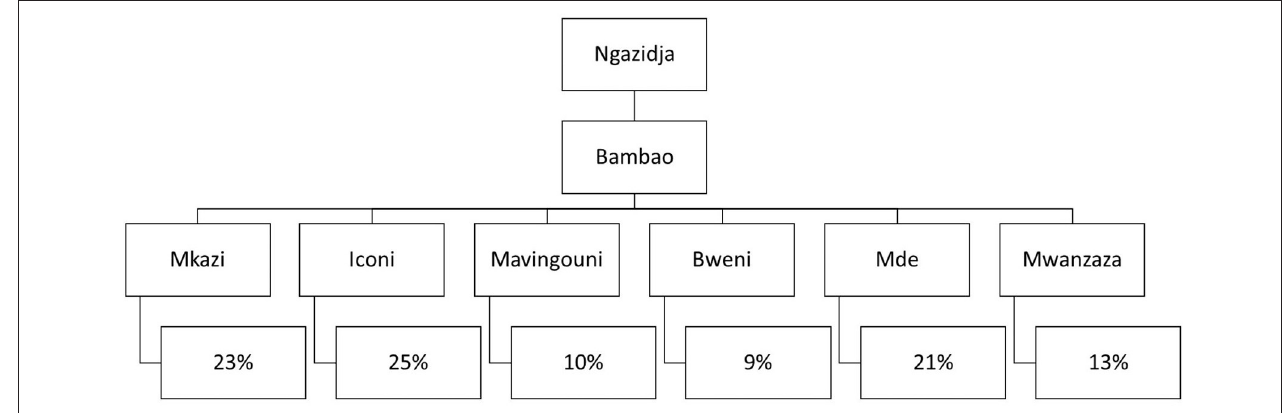
FIGURE 1 | Recruitment pattern of the sample in respective